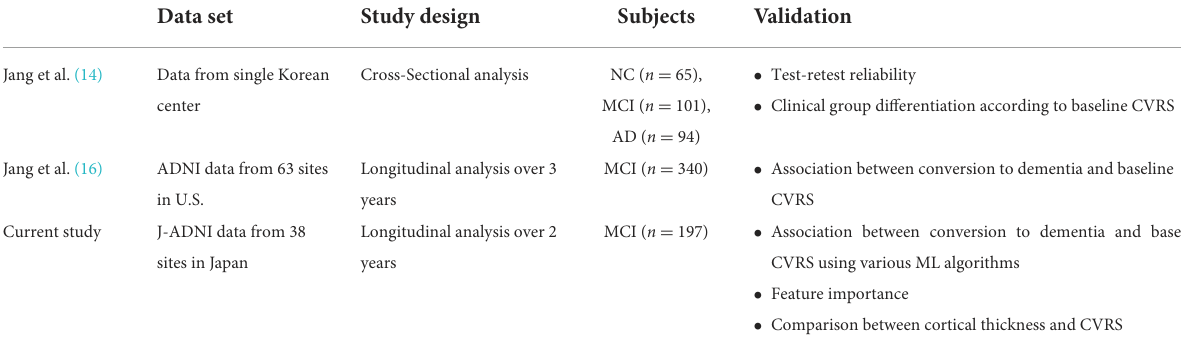
TABLE 4 Comparison of studies using comprehensive visual rating scale